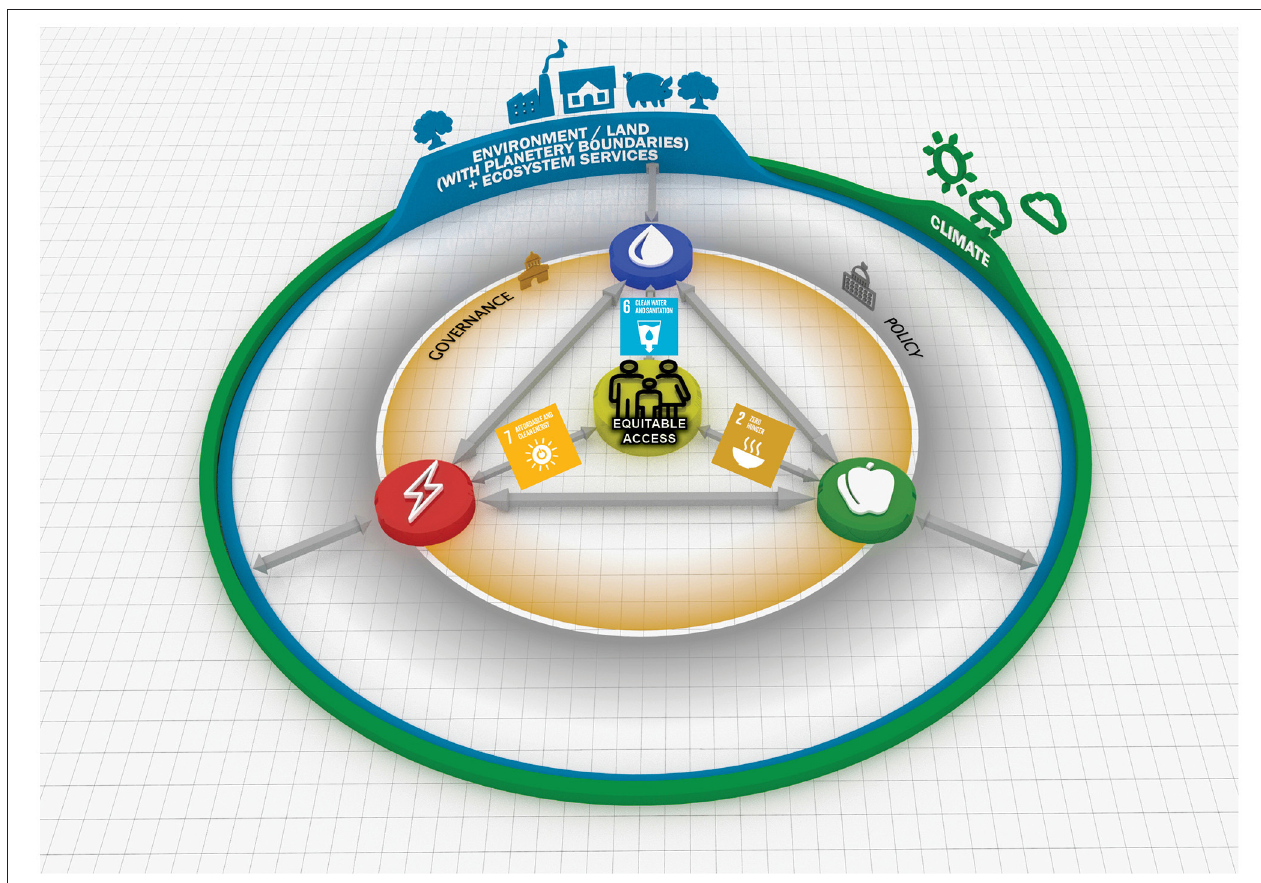
FIGURE 1 | The Anthropocentric WEF nexus framework (from Simpson et al., 2020).